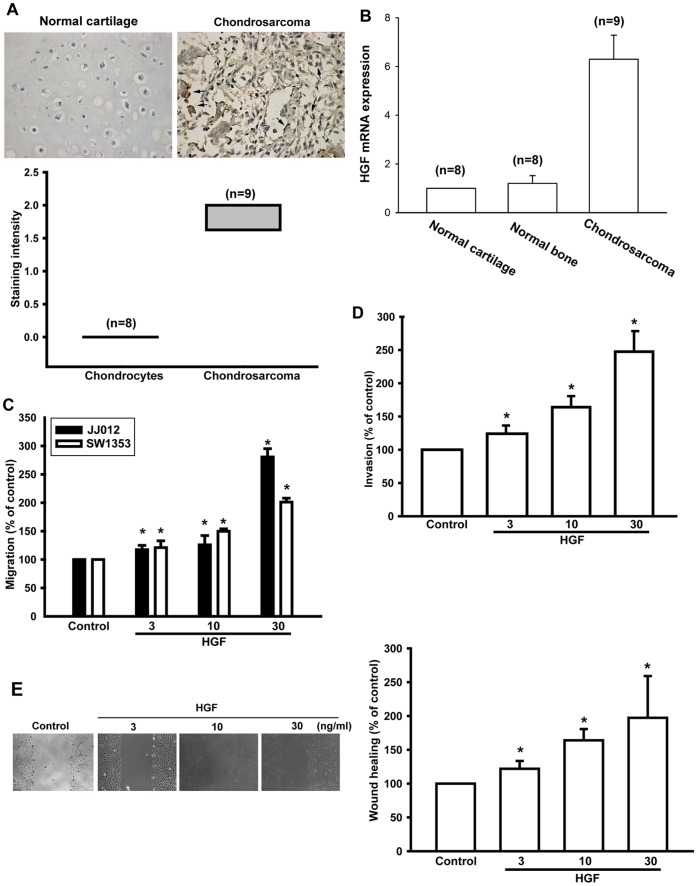
HGF induced the migration of human chondrosarcoma cells.(A) Immunohistochemistry showing HGF expression in normal cartilage and chondrosarcoma tissues (arrow shows HGF staining). Quantitative data are shown in the lower panel. (B) Quantitative PCR analysis for HGF mRNA expression in normal cartilage, normal bone, and chondrosarcoma tissues. (C and D) Cells were incubated with HGF (3–30 ng/mL), and in vitro migration and invasion was measured by Transwell assay after 24 h. (E) JJ012 cells were treated with HGF for 24 h, after which the wound-scratching assay was performed. Results are expressed as mean ± S.E. *p<0.05 compared with control; #p<0.05 compared with HGF-treated group.